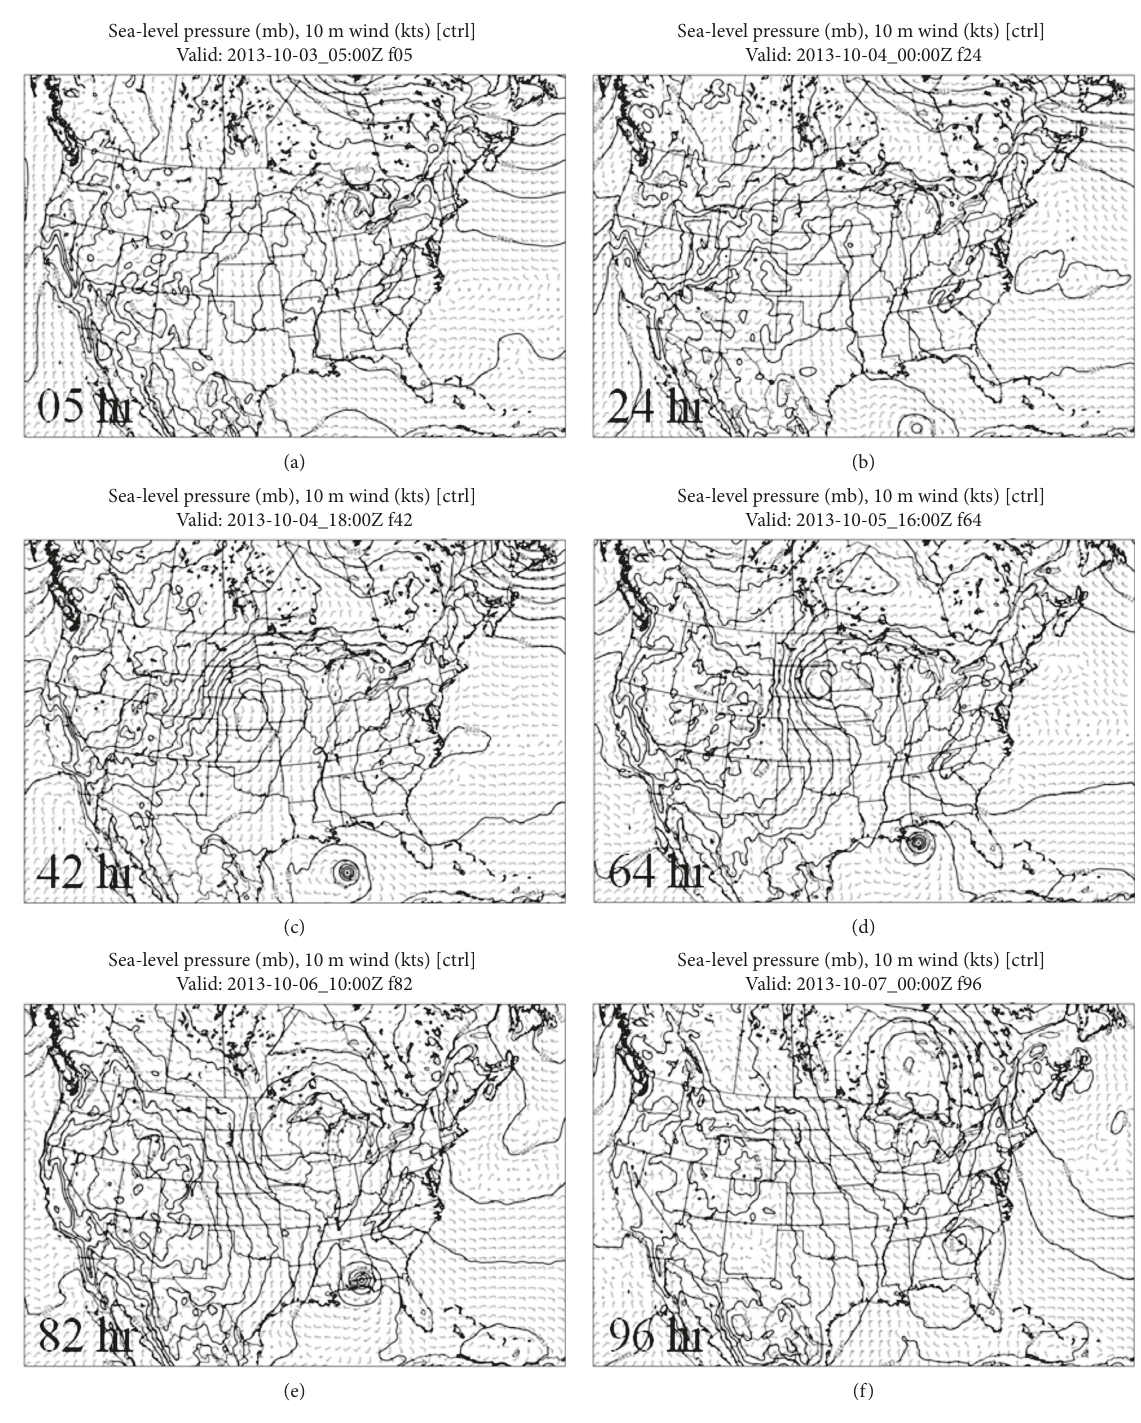
Figure 9: Surface sea-level pressure and 10m wind speed at forecast hours 05 (a), 24 (b), 42 (c), 64 (d), 82 (e), and 96 (f) for the 3 October 2013 control